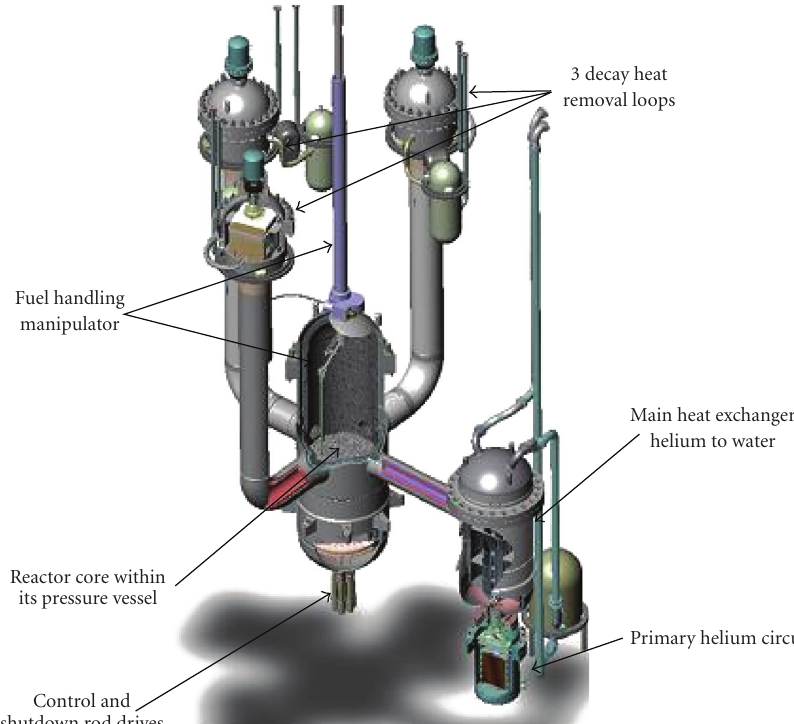
Figure 1: Proposed layout of ALLEGRO, the GFR